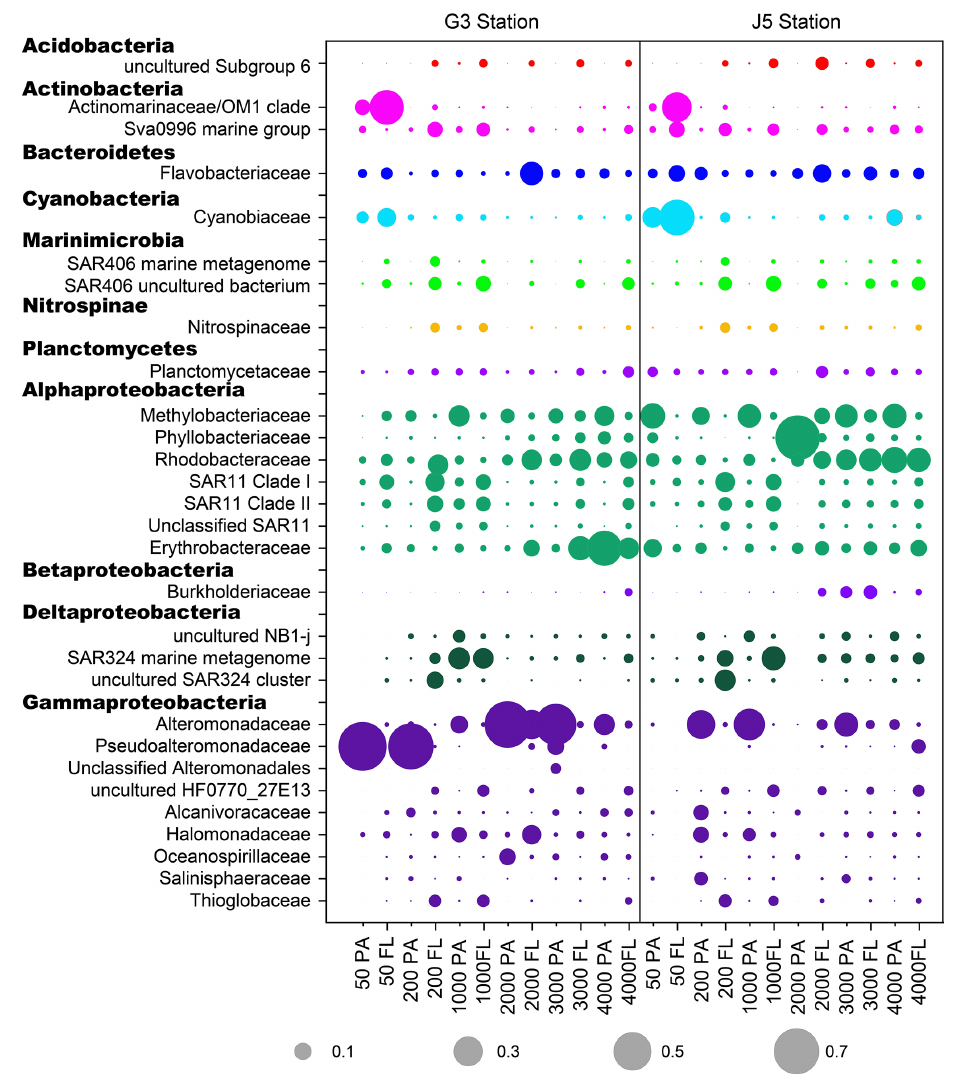
Figure 6. The relative abundances of families in particle-attached and free-living bacterial communities. Dark grey bubbles are the average relative abundances in the PA fraction, while light grey bubbles are the average relative abundances in the FL fractions. Scale is shown at the bottom, and the circle with a number indicates the actual relative